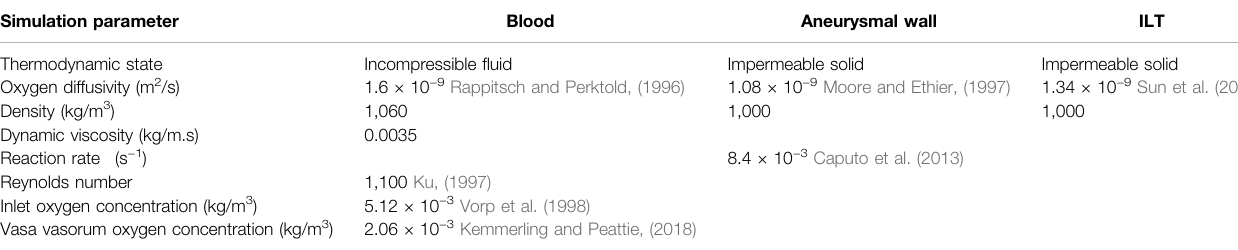
TABLE 2 | Physical parameters and material properties for AAA model